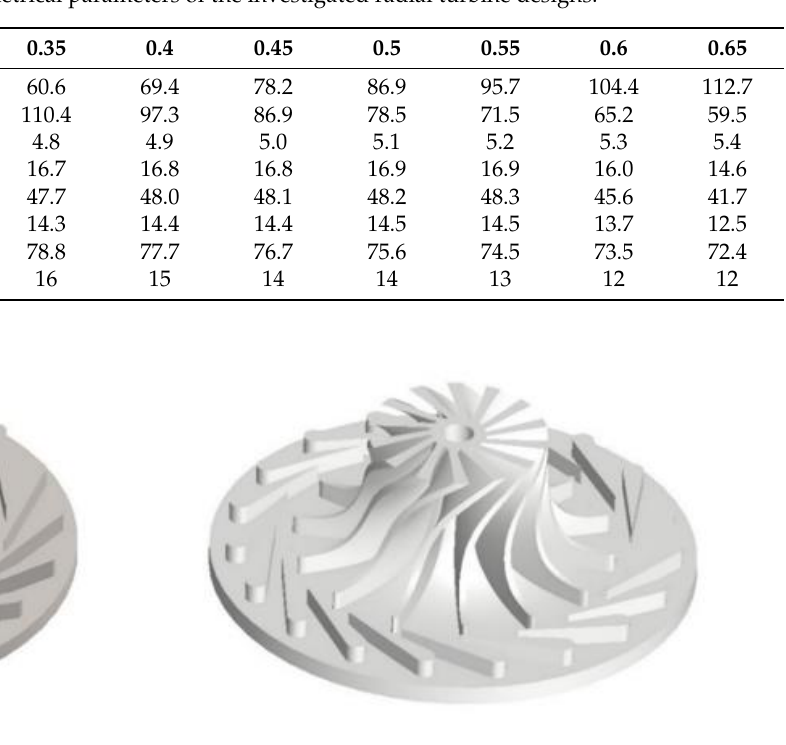
Table 2. Main geometrical parameters of the investigated radial turbine designs.